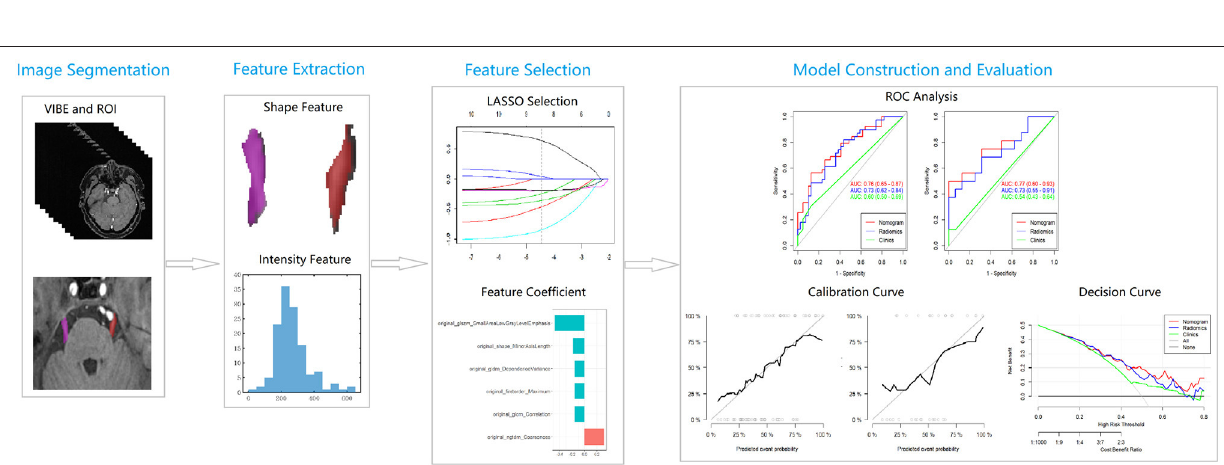
FIGURE 1 | An example of TPA measurement. Along the main axis of the trigeminal nerve, the point emanating from the brainstem through the trigeminal nerve is tangential to the pons, and the angle is composed of the two lines. (A) An example of TPA measurement of the patient and (B) TPA drawn by hand. TPA, trigeminal pons angle.